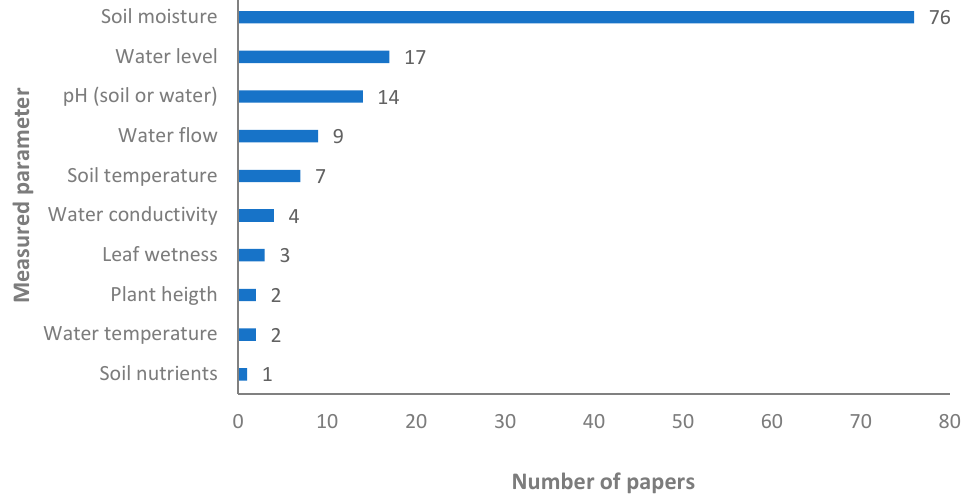
Figure 7. Monitored parameters from the soil, water, and plants in papers that propose an irrigation system.